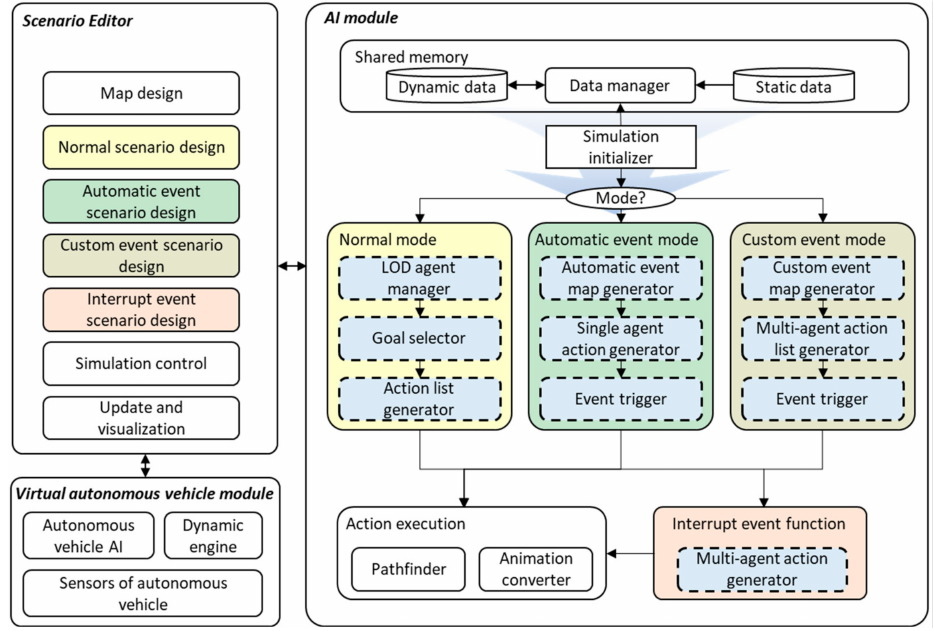
Figure 1. Architecture of the proposed scenario simulation framework. AI: artificial